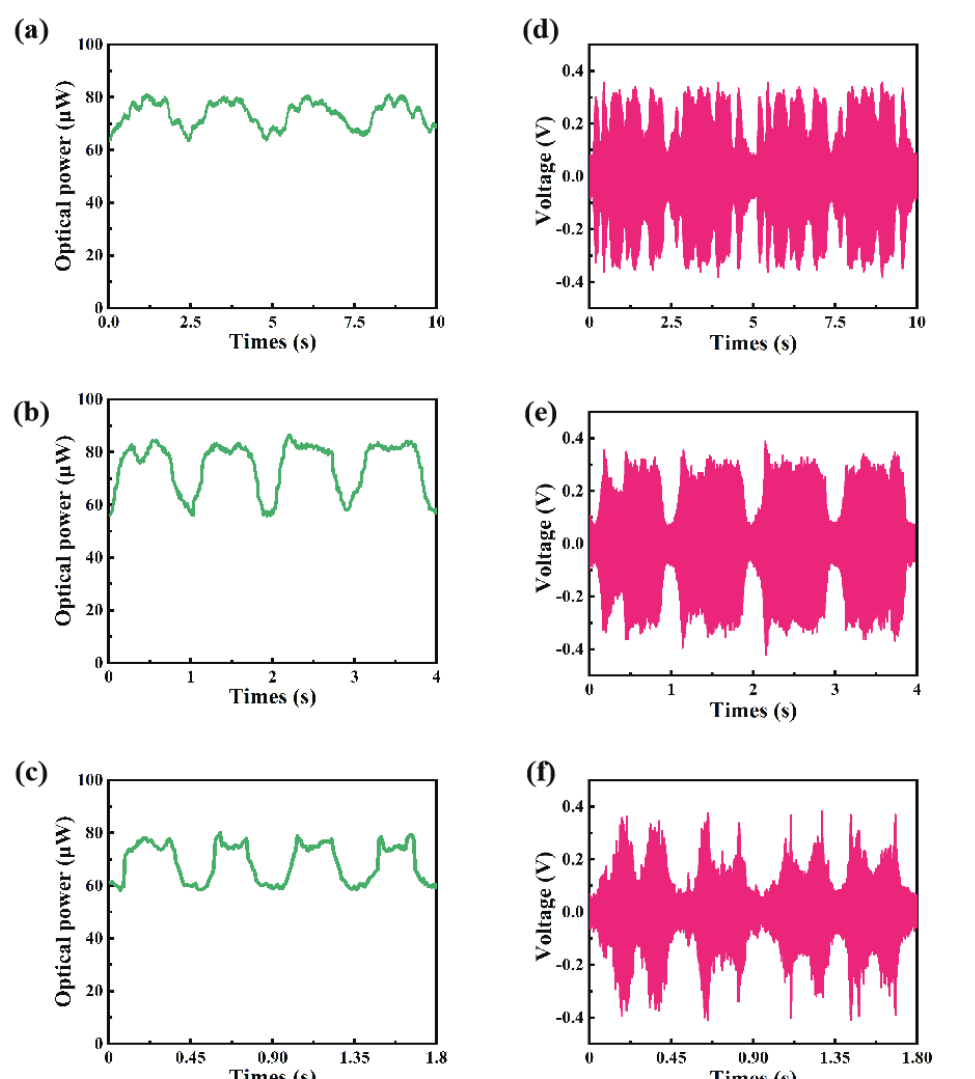
Figure 9. Optical power variation curve versus different waves frequencies of ( a ) 0.4 Hz, ( b ) 1 Hz and ( c ) 2.2 Hz; waveform diagram versus different optical power frequencies of ( d ) 0.4 Hz, ( e ) 1 Hz and ( f ) 2.2 Hz at a data rate of 240